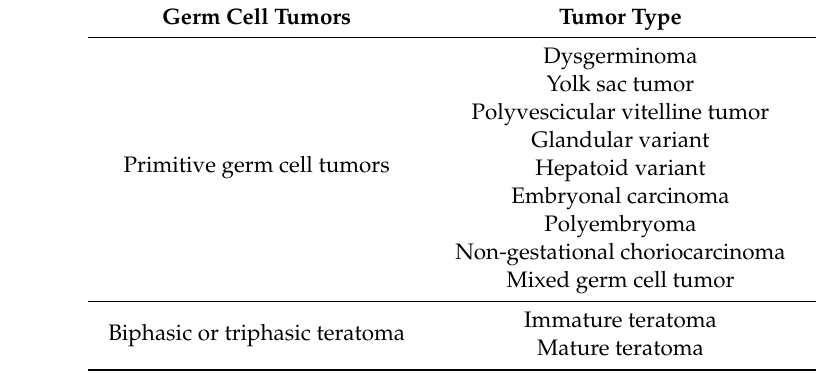
Table 1. Malignant ovarian germ cell tumors classification (according to the World Health Organization (WHO) classification of tumors) [5].